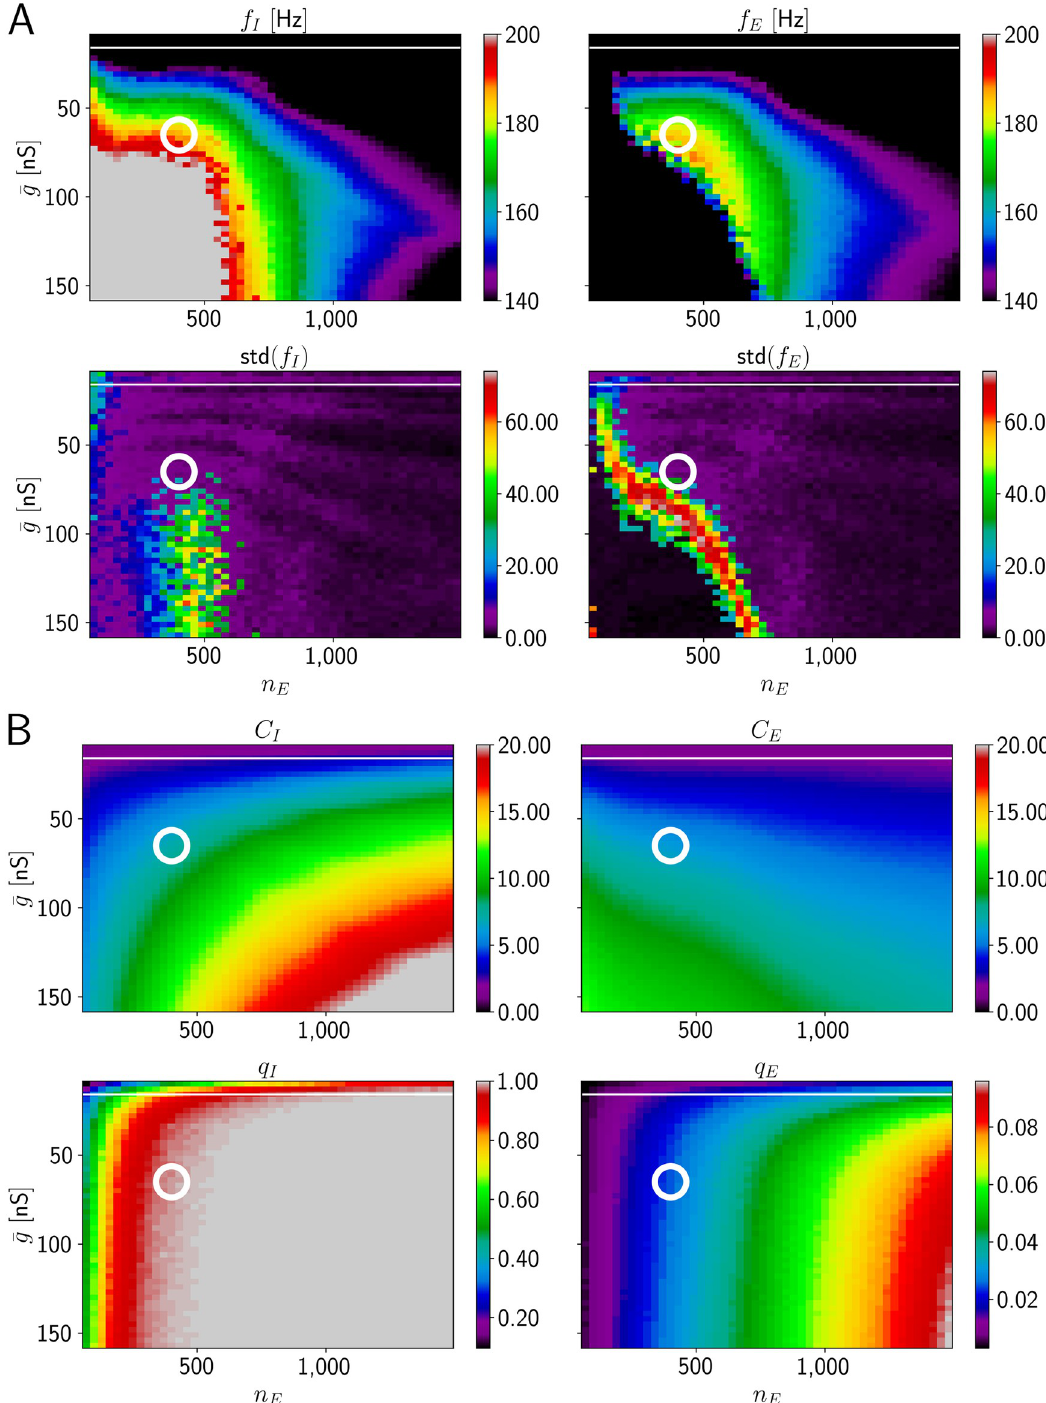
Fig 4. HFOs in networks with temporally broad excitation of E cells (model 1). There is no overlap of the parameter region with reliable ripple oscillation generation and sparse spiking of E neurons. A, upper subpanel: Frequency of I and E population activity oscillations f I , f E as a function of mean drive � g and number of excited E cells n E (average taken across different network realizations). Lower: Corresponding standard deviations across network realizations, std( f spikes per active inhibitory (excitatory) neuron, C I ( C E ). Lower: fraction of active neurons ( q I and q E ). The range for f I and f E displayed in detail by different colors is the ripple range, [140, 200] Hz. The range for both C